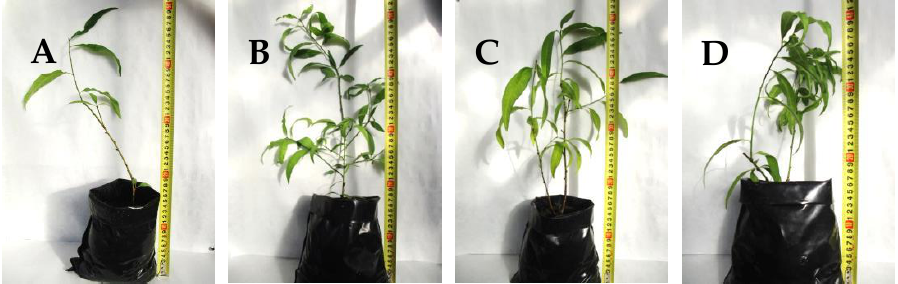
Figure 4. Adapted peach seedlings: ( A ) ‘Clyde Wilson’ × ‘Nikitskiy Podarok’; ( B ) ‘Jerseyglo’ × ‘Nikitskiy Podarok’; ( C ) ‘Loadel’ × ‘Nikitskiy Podarok’; ( D ) ‘Summerglo’ × ‘Nikitskiy Podarok’ .